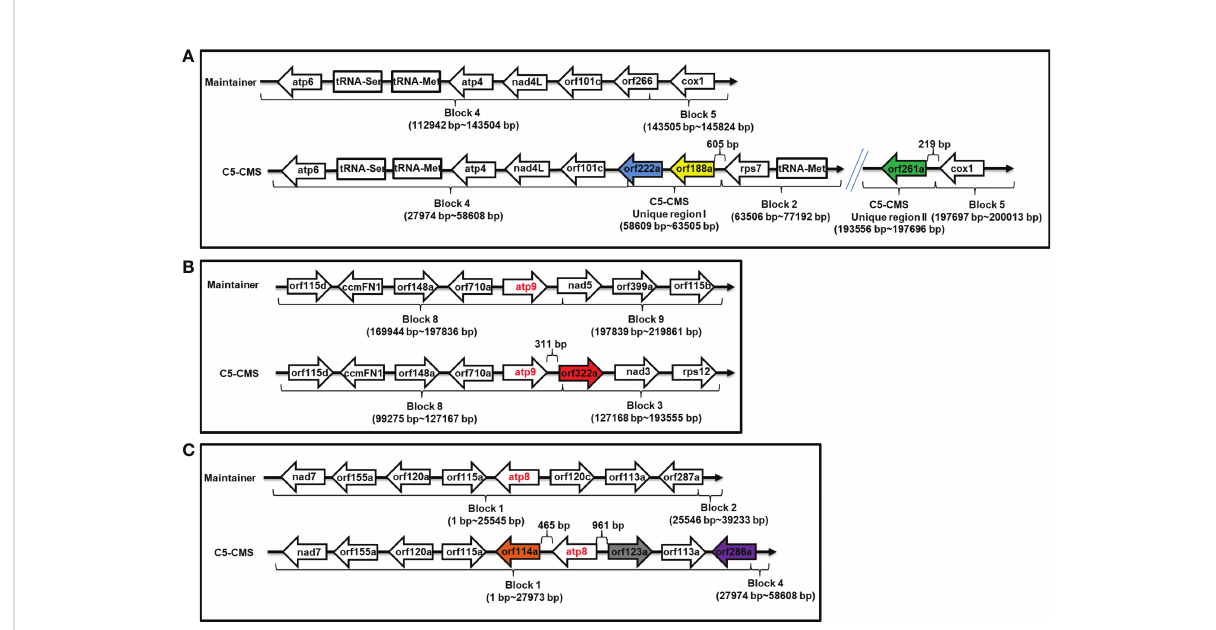
FIGURE 7 Organization of mitochondrial genome regions associated with candidate sterility genes for C5-type CMS. (A) Genome structure of the orf188a, orf222a, and orf261a regions. (B) Genome structure of the atp9 and orf322a regions. (C) Genome structure of the atp8, orf114a, orf123a and orf286a regions. The corresponding genes within the regions between the maintainer and C5-type CMS genomes areindicated by boxes. Two recombination events occurred in the C5-type CMS genome. Unique region I was inserted between the block 4 and block 2 syntenic regions, and orf188a and orf222a are located in unique region I. Unique region II was the result of recombination between the block 3 and block 5 syntenic regions, and orf261a is located in this